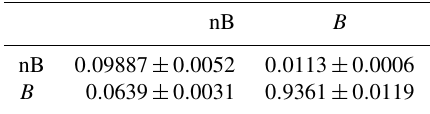
Table 2. Probability estimates ± standard errors (SE) for the two- state model. Probabilities give the transition to the state given in the column conditioned on the state given in the row.